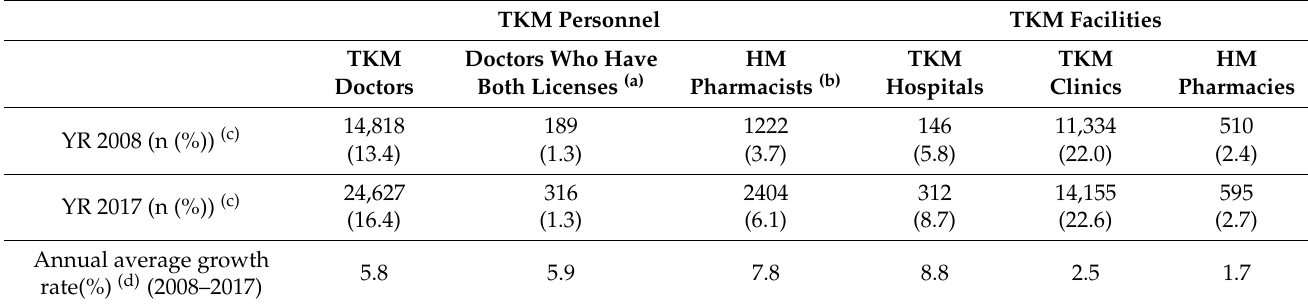
Table 1. Changes in the number of Traditional Korean Medicine personnel and facilities in Korea (2008–2017). TKM